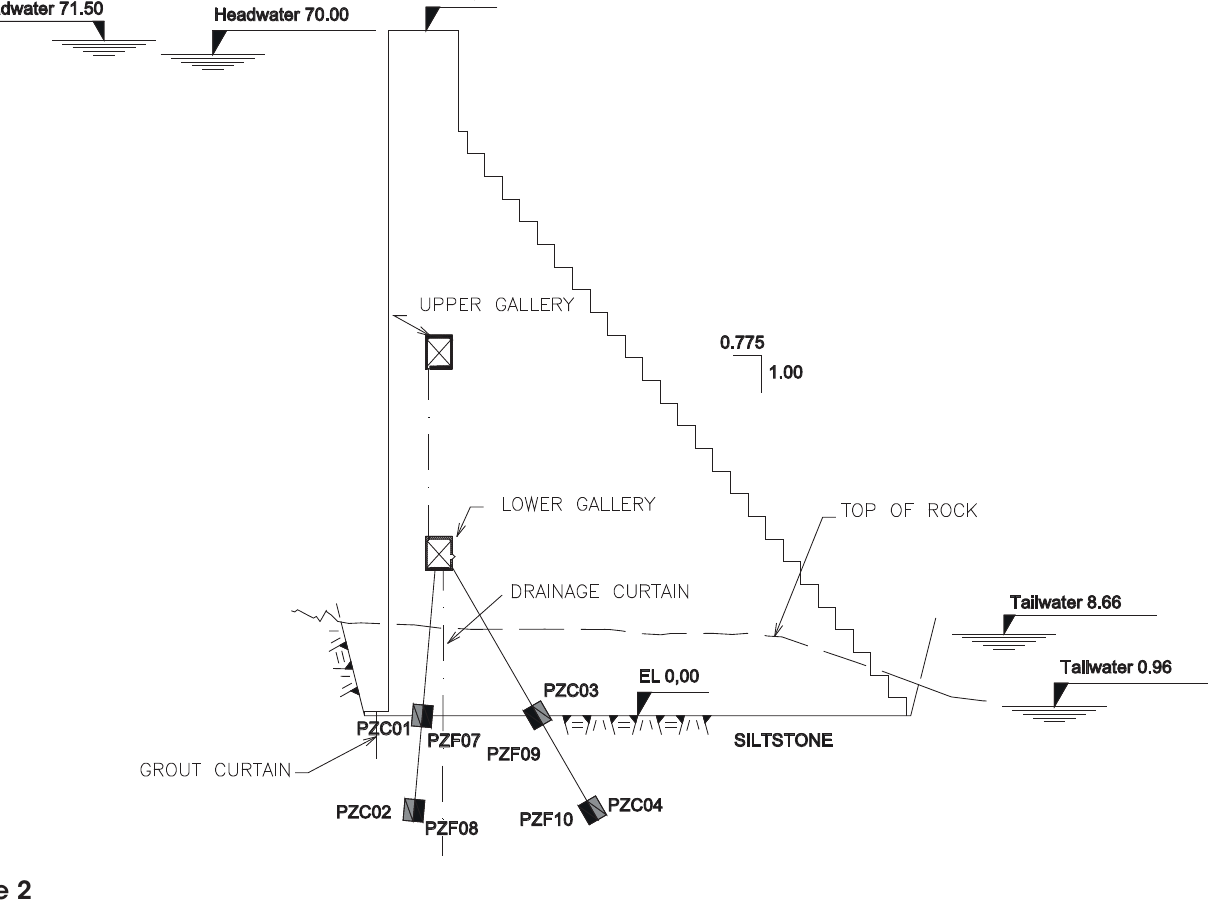
Figure 2 Piezometers installed in block n. 30 of the